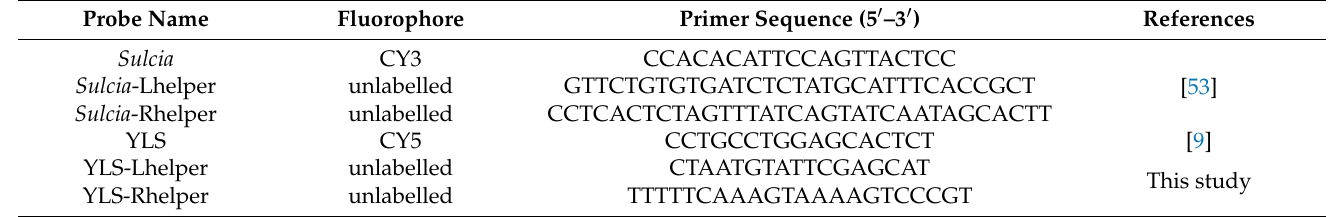
Table 1. Probes used for the fluorescence in situ hybridization of Sulcia and YLS of two cicada species.